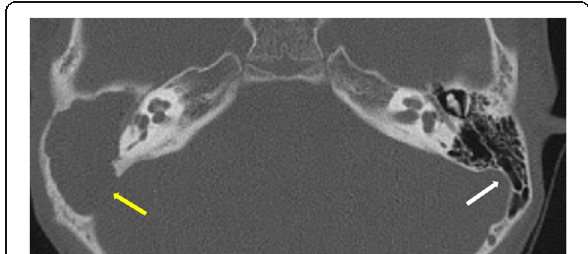
Fig. 7 Axial CT shows normal “ ice cream cone ” configuration of ossicles in epitympanum on the left side formed by the head of the malleus and the body of the incus. The right ear shows soft tissue in the middle ear and aditus with non-visualization of ice cream cone suggesting erosion. A large defect is also seen in the sinodural plate on the right side (yellow arrow). Left sinodural plate is intact (white arrow)